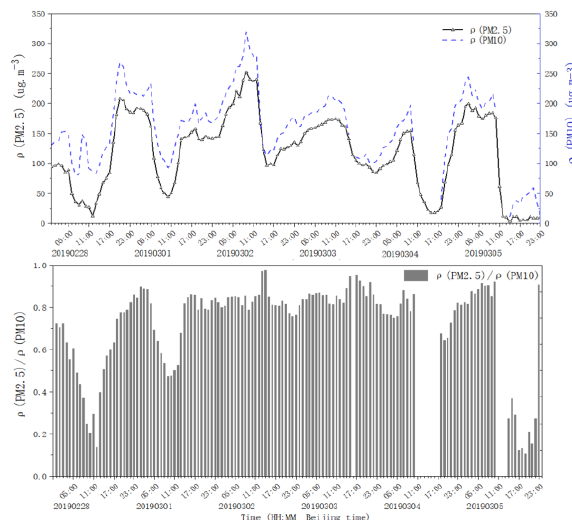
Figure 3. Concentration of PM2.5 and PM10 ( the upper) ,